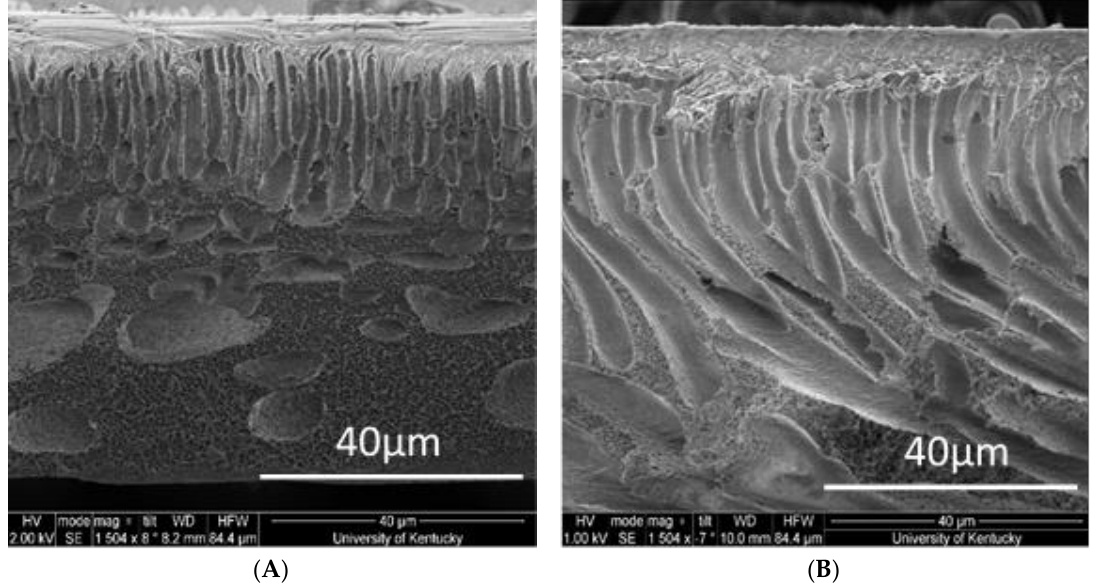
Figure 11. Cross-section images of ( A ) SPEEK:PSf membrane and ( B ) and phosphorene membrane .